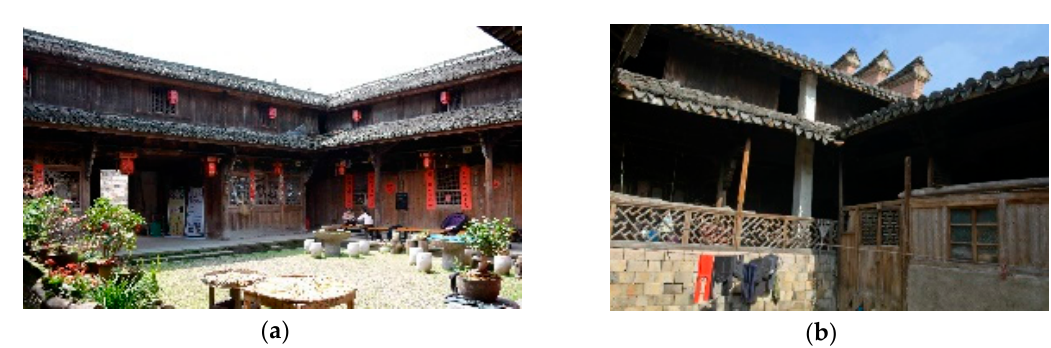
Figure 9. Interior courtyard facades in ( a ) Heyang and ( b ) Danzhi.